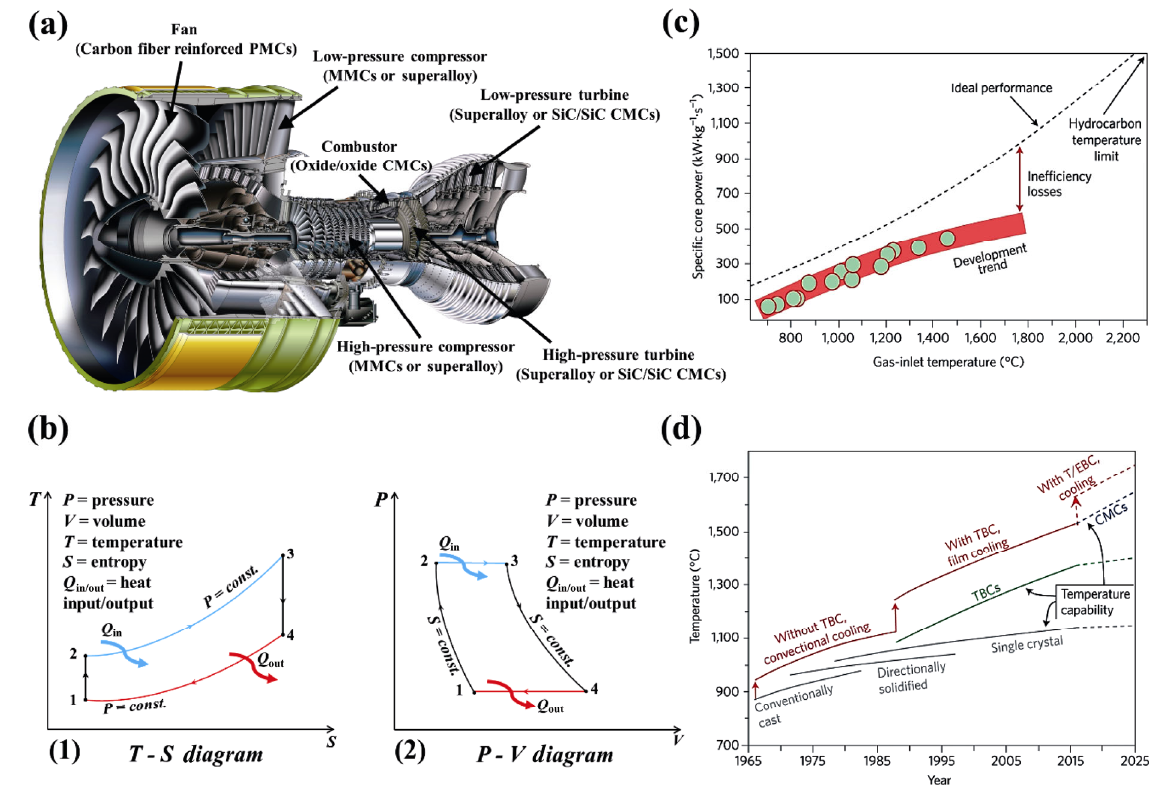
Fig. 6 (a) Cutaway view of GP7200 aircraft engine (retrieved from https://prattwhitney.com/products-and-services/products/ commercial-engines/gp7200) and the potential applications of continuous fiber reinforced composites (PMCs: polymer matrix composites; MMCs: metal matrix composites; CMCs: ceramic matrix composites) [282]. (b) T–S (1) and P–V (2) diagrams of an ideal Brayton cycle. Reproduced with permission from Ref. [1], © Elsevier Ltd. 2020. (c) Specific core power of a gas-turbine engine as a function of gas-inlet temperature, and (d) progression and projection of temperature capabilities of Ni-based superalloy (grey), TBCs (green, rough estimates), CMCs (blue, rough estimates), and maximum allowable gas temperatures with cooling (red, rough estimates). Reproduced with permission from Ref. [283], © Nature Publishing Group, a division of Macmillan Publishers Limited